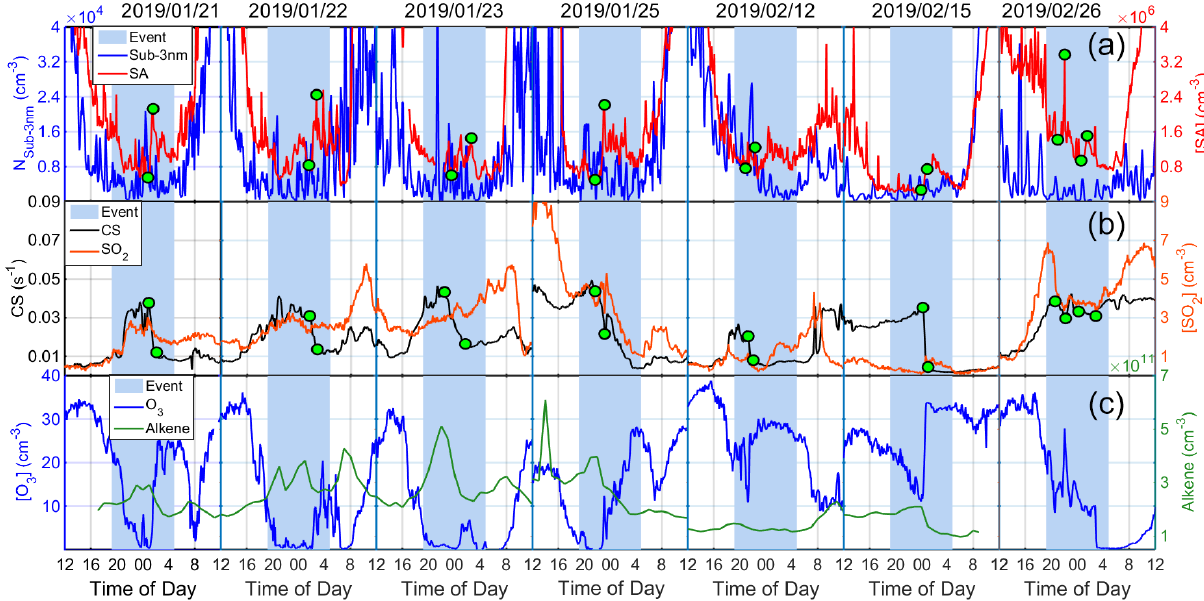
Figure 4. Daily time series of different variables on nighttime SA event days when SA events occurred under CS decrease conditions. Panel (a) shows the N sub-3nm and SA concentration, (b) shows CS and SO 2 concentration, and (c) shows the concentration of O 3 and alkenes. Green dots show times when CS started to drop and reached its minimum